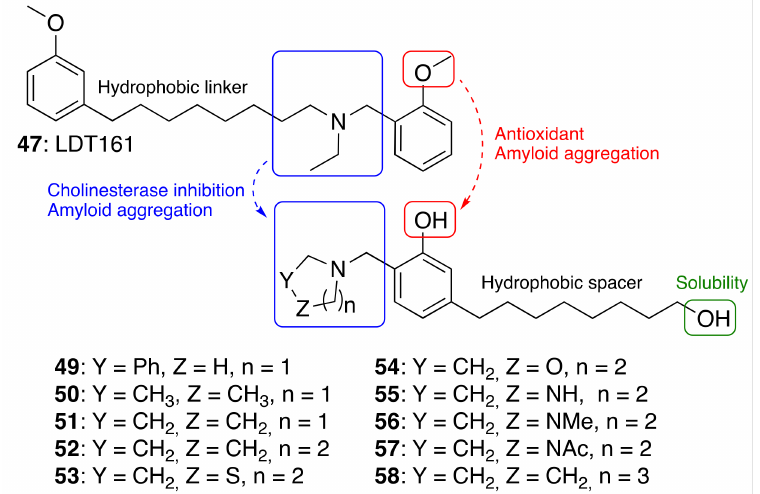
Figure 8. Cardanol-derived multifunctional compounds 49 – 58 .